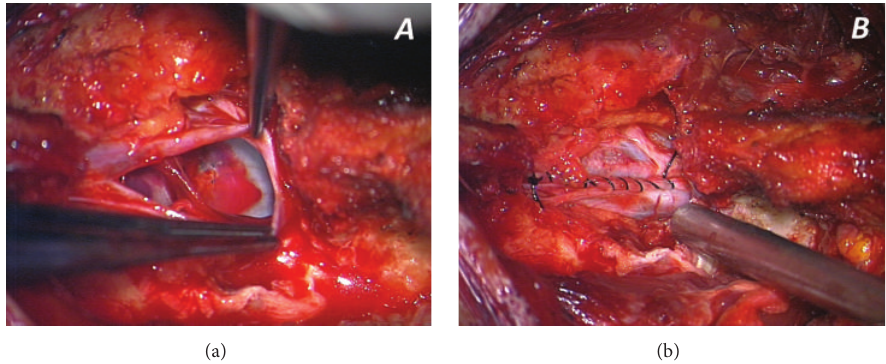
Figure 4: Intraoperative pictures from the high resolution microscope. (a) The dural laceration, with sacral roots contused, and the impact point of the penetrating object in the anterior part of the dural sac, at the level of the posterior wall of S1 vertebral body; in the middle of the contusion some little graphite pigments from the pencil tip can be seen. (b) The watertight closure of the dural